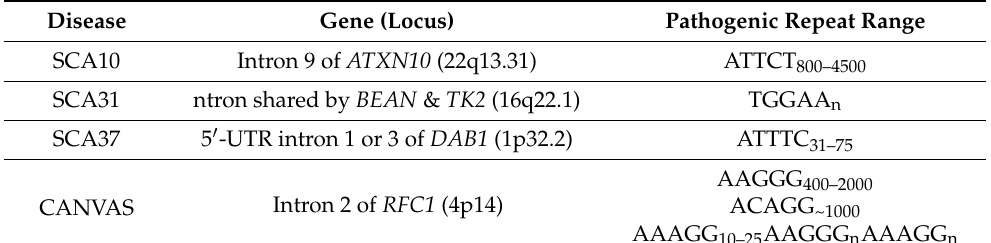
Table 1. Pentanucleotide expansion diseases with their characteristic pathogenic alleles. Disease Gene (Locus) Pathogenic Repeat Range SCA10 Intron 9 of ATXN10 (22q13.31) ATTCT 800–4500 SCA31 ntron shared by BEAN & TK2 (16q22.1) TGGAA n SCA37 5 (cid:48) -UTR intron 1 or 3 of DAB1 (1p32.2) ATTTC 31–75 CANVAS Intron 2 of RFC1